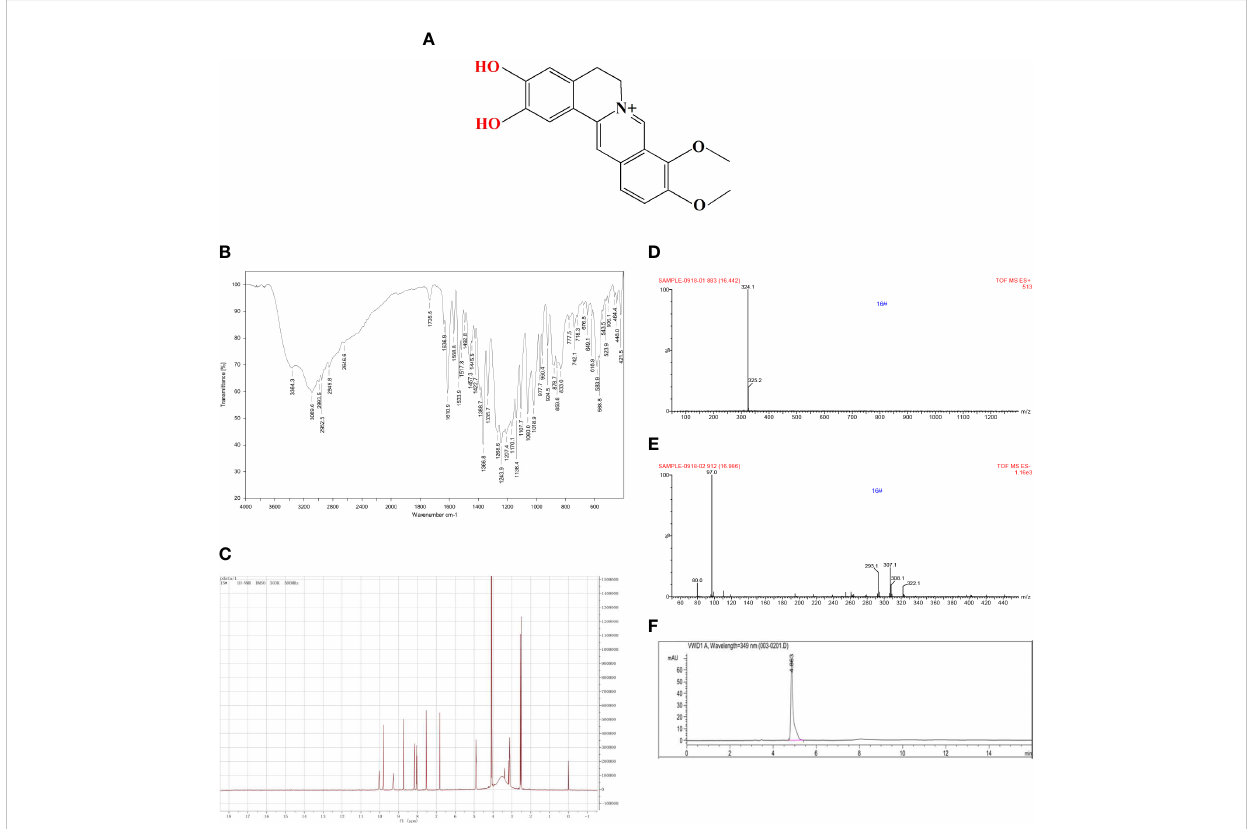
FIGURE 1 Quality control of DMB. (A) The structure of DMB. (B) The IR spectrum of DMB. (C) The 1 H-NMR spectrum of DMB. (D, E) The MS spectrum of DMB. (F) The speci fi c fi ngerprint spectrum of DMB by